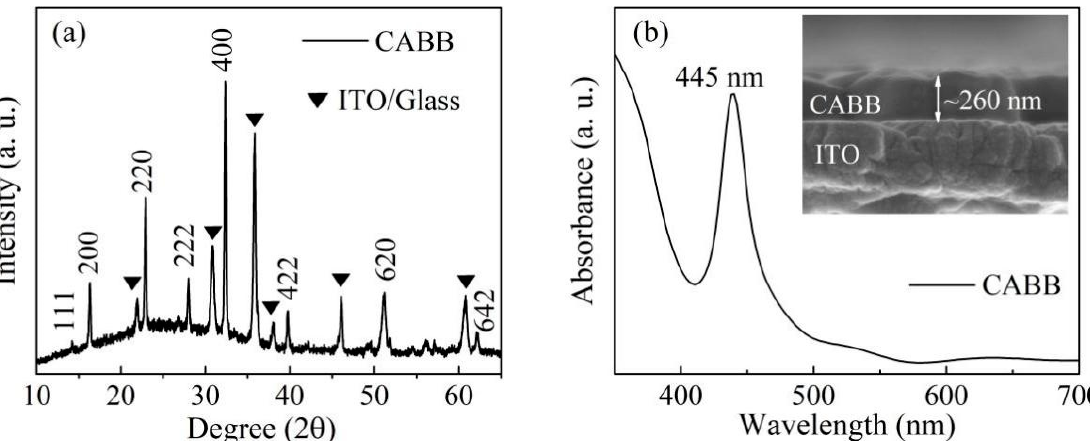
Figure 1. Basic physical characteristics of CABB films. ( a ) XRD patterns of the cubic CABB film; ( b ) optical absorption spectrum of the CABB film. The inset displays the cross-sectional SEM image of CABB layers spin-coated on the ITO/glass substrate.